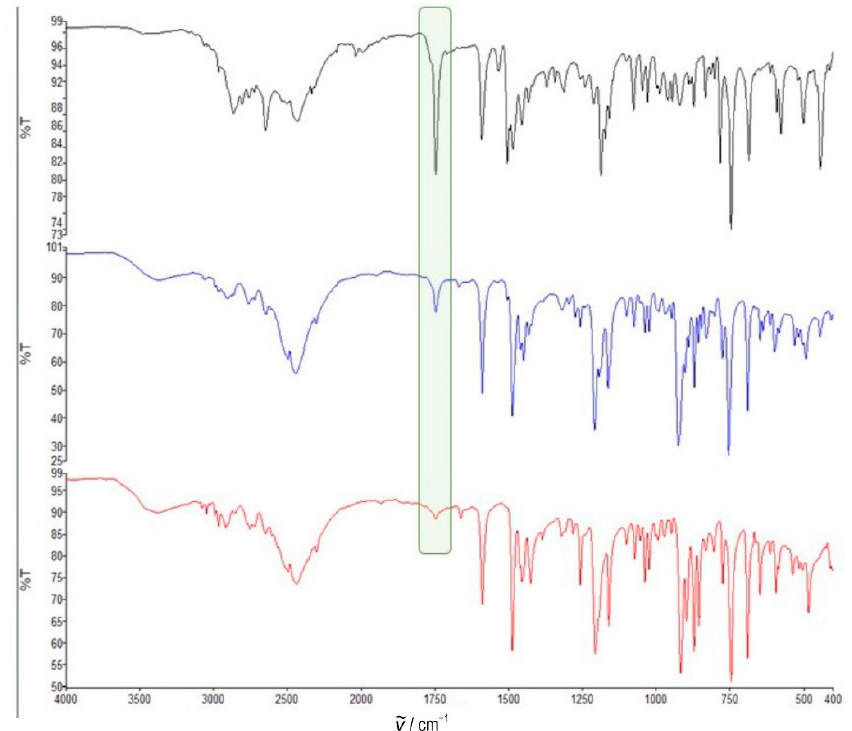
Figure 3. Monitoring of mechanochemical reaction of quinuclidin-3-one hydrochloride and O -phenylhydroxylamine hydrochloride with potassium carbonate (product 4·HCl ) by ATR spectroscopy of the crude reaction mixture (black, 1 min, blue, 3 min, red, 6 min). Carbonyl peaks at 1750 cm − 1 are highlighted with a green rectangle.